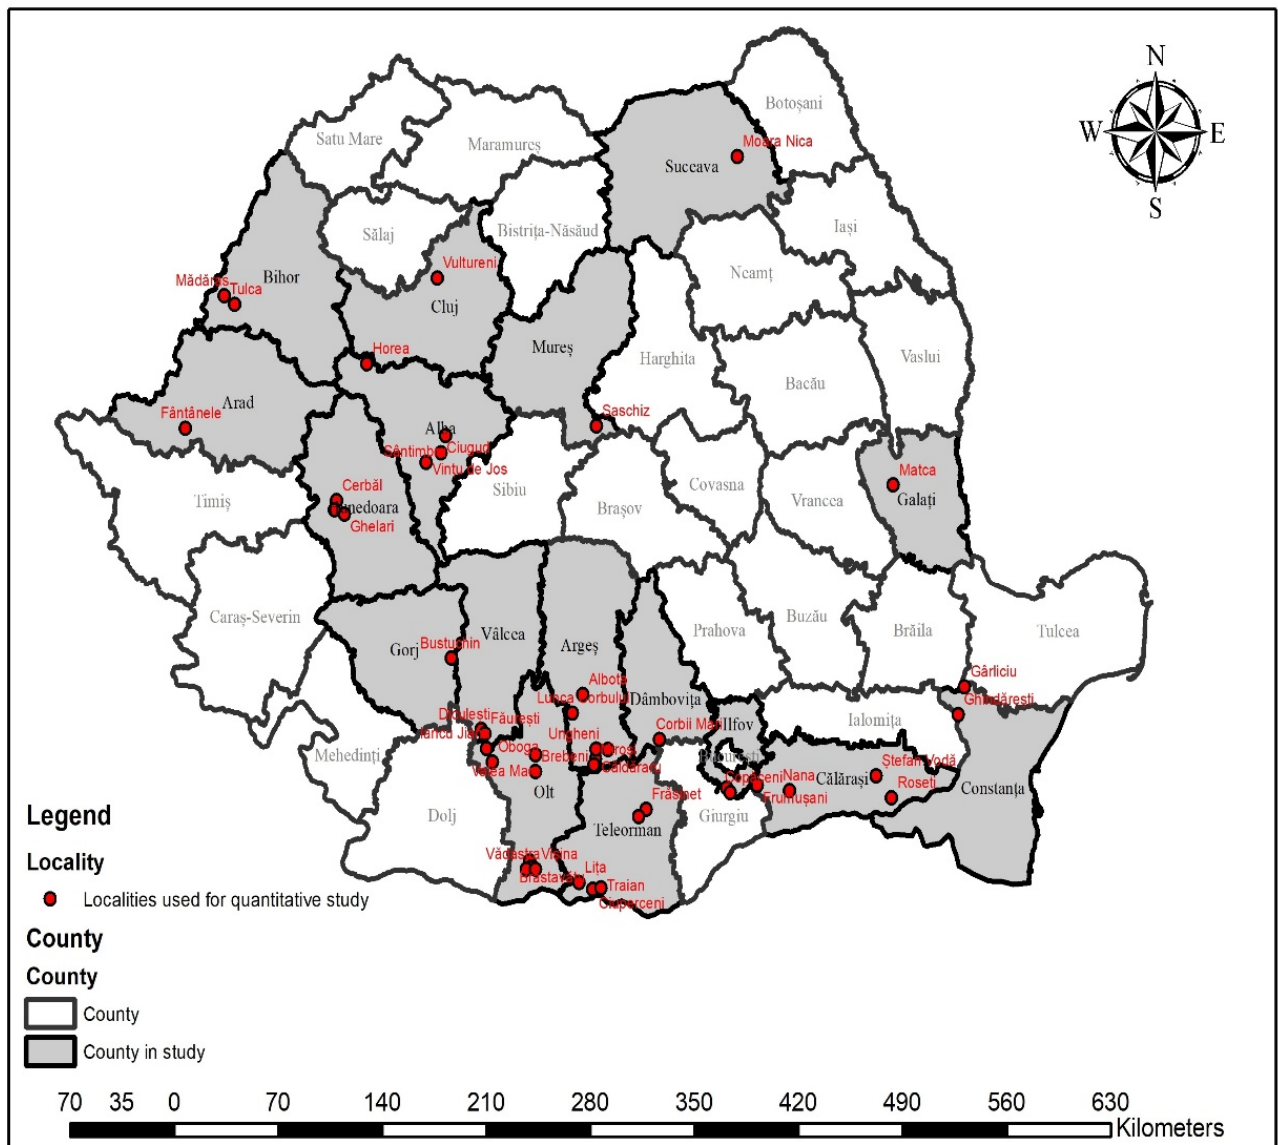
Figure 2. Map of the distribution of the localities selected for the quantitative study regarding the principle of aerial images rather than field surveys.